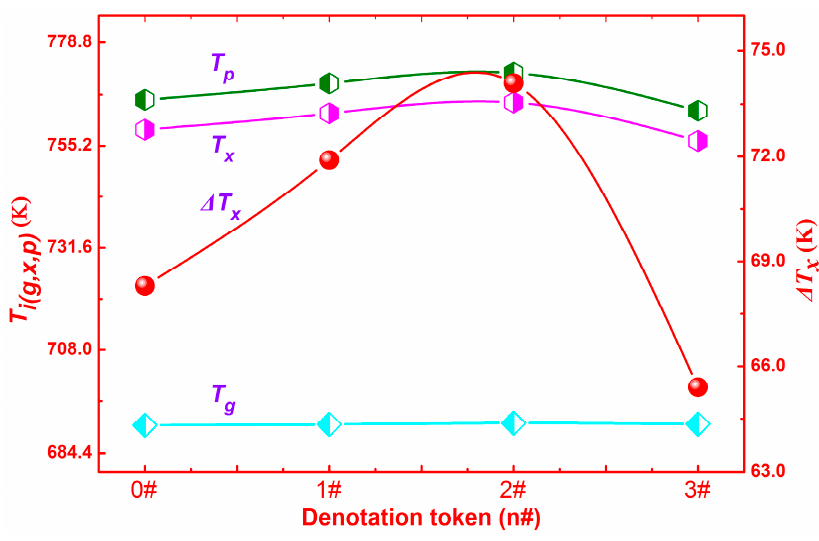
Figure 4. The variations of thermodynamic parameters for the BMG matrix and welds processed with different currents.